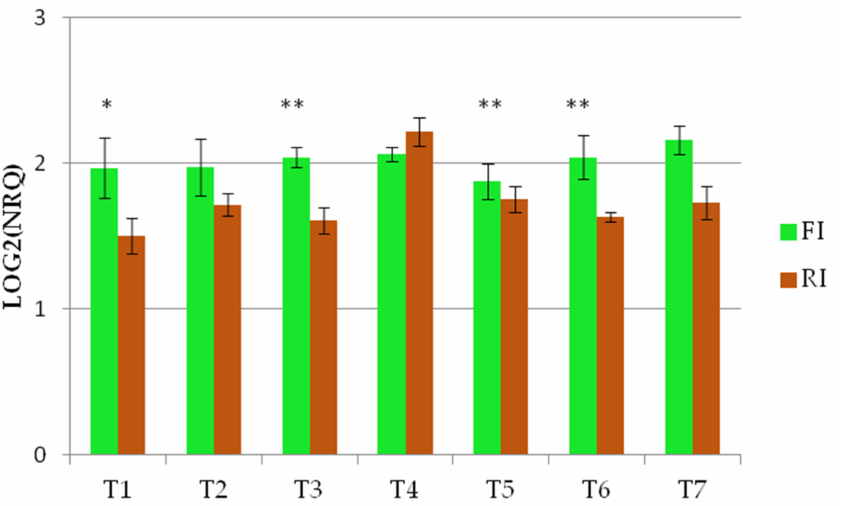
Figure 5. The expression profile of Wdhn13 transcript of Barnacla under FI and RI conditions ** p < 0.01, * p <